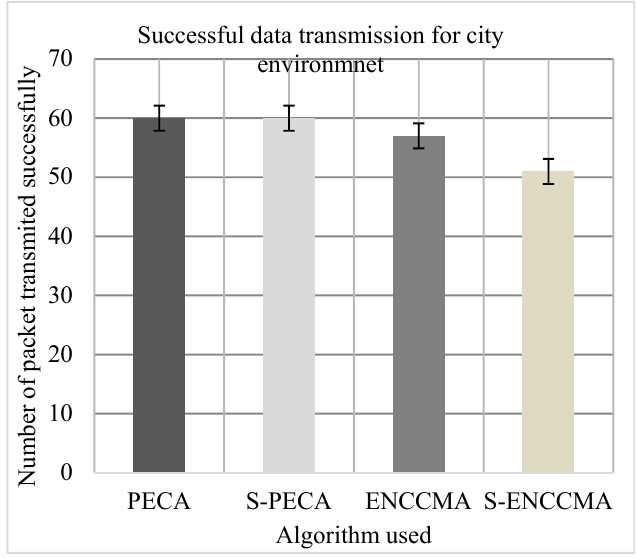
Figure 13. Successful transmission performance for city.